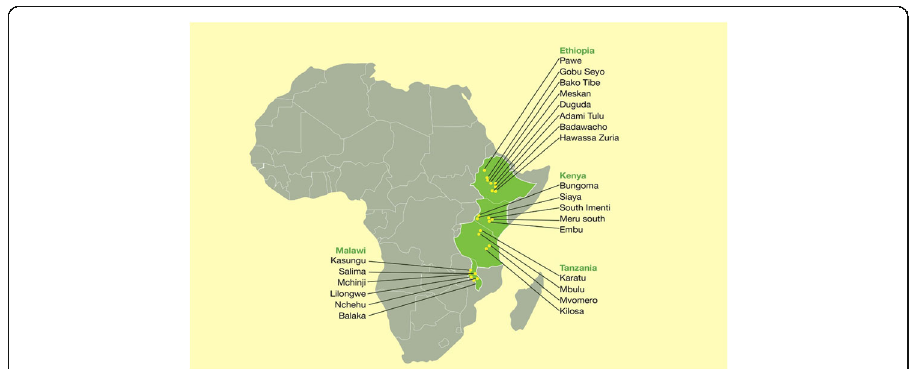
Fig. 1 Key study locations in Ethiopia, Kenya, Malawi and Tanzania (due to space limitations, not all the 39 districts in Ethiopia are displayed. The figure represents the range of agro-ecologies covered in the Ethiopia